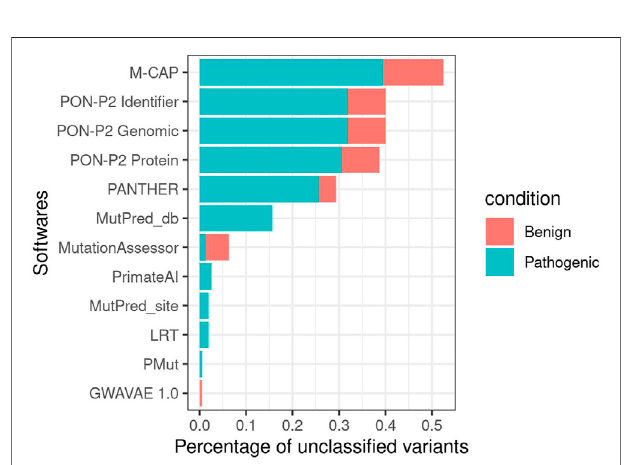
FIGURE 5 | Number of unclassi fi ed variants per software for the less stringent criteria subset.